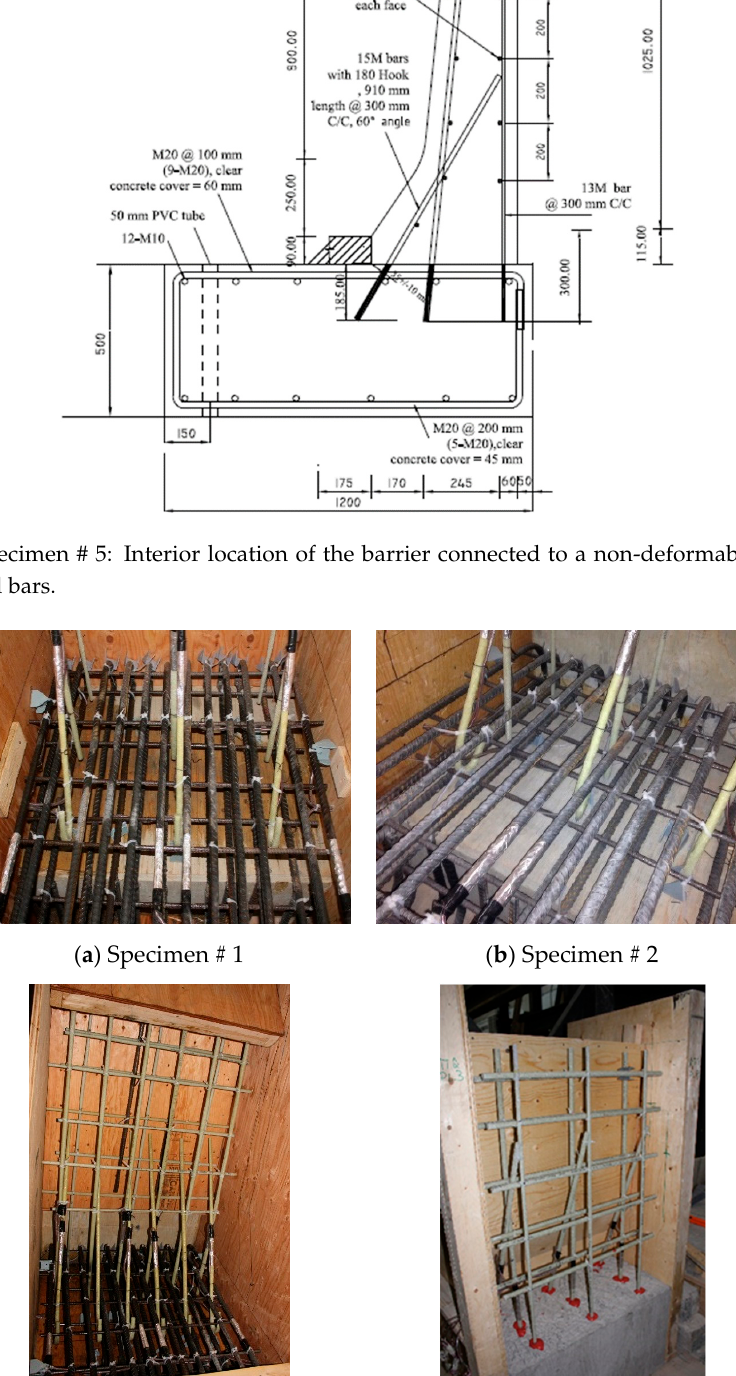
Figure 8. Views of the formwork and reinforcement details. ( a ) Specimen # 1; ( b ) Specimen # 2; ( c ) Specimen # 3; ( d ) Specimen # 5. ( c ) Specimen # 3; ( d ) Specimen #